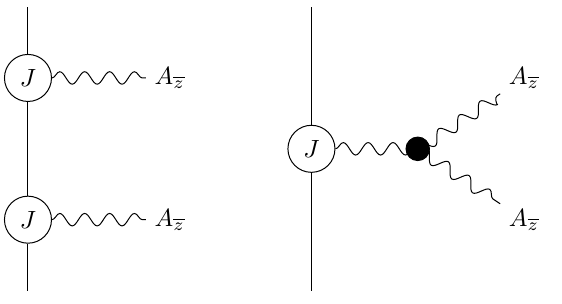
Figure 3 . Cancellation of the gauge anomaly of these two diagrams leads to the OPEs of the currents J [ k ] 1 , k 2